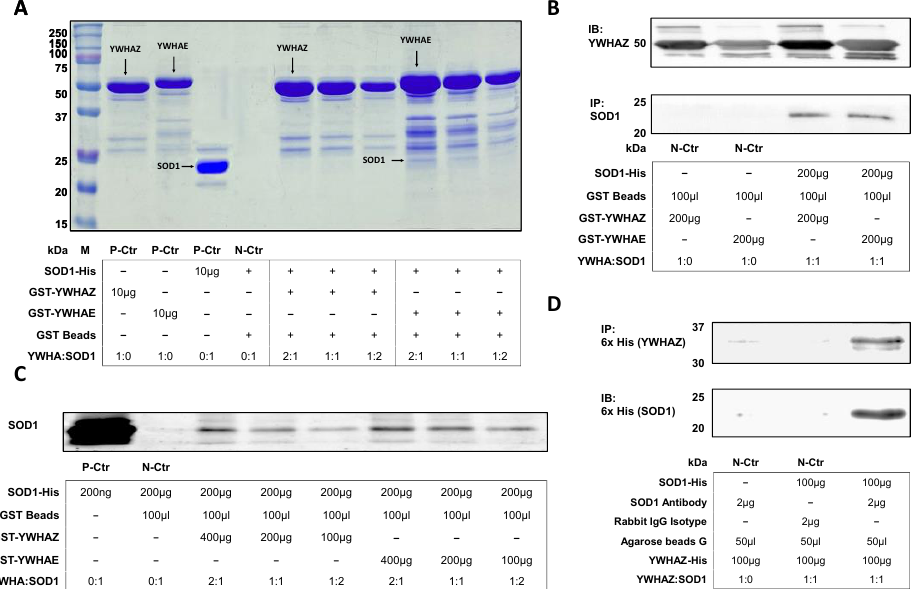
Figure 2. Evidence for protein – protein interaction complex formation of YWHAZ-SOD1 and YWHAE-SOD1. ( A ) A representative SDS-PAGE image with Coomassie blue staining showed the protein complex formation between purified GST-YWHAZ or GST-YWHAE immobilized on glutathione sepharose beads and the purified SOD1-His at different ratios. P-Ctr: positive control. N-Ctr: Negative control. ( B ) A representative image of immunoblots of YWHAZ and SOD1 with samples of the same protein complexes (GST-YWHAZ&SOD1-His or GST-YWHAE&SOD1-His) eluted from the glutathione sepharose beads. ( C ) A representative image of immunoblots of SOD1 with the same protein complexes (GST-YWHAZ&SOD1-His, or GST-YWHAE&SOD1-His) eluted from the glutathione sepharose beads at different ratios. ( D ) A representative image of the immunoprecipitation pull-down showed the binding protein complex formation between purified SOD1-His with anti-SOD1 antibody immobilized on agarose beads G. The eluates were subjected to SDS-PAGE (12% gel) and immunoblotted by the anti-His antibody.